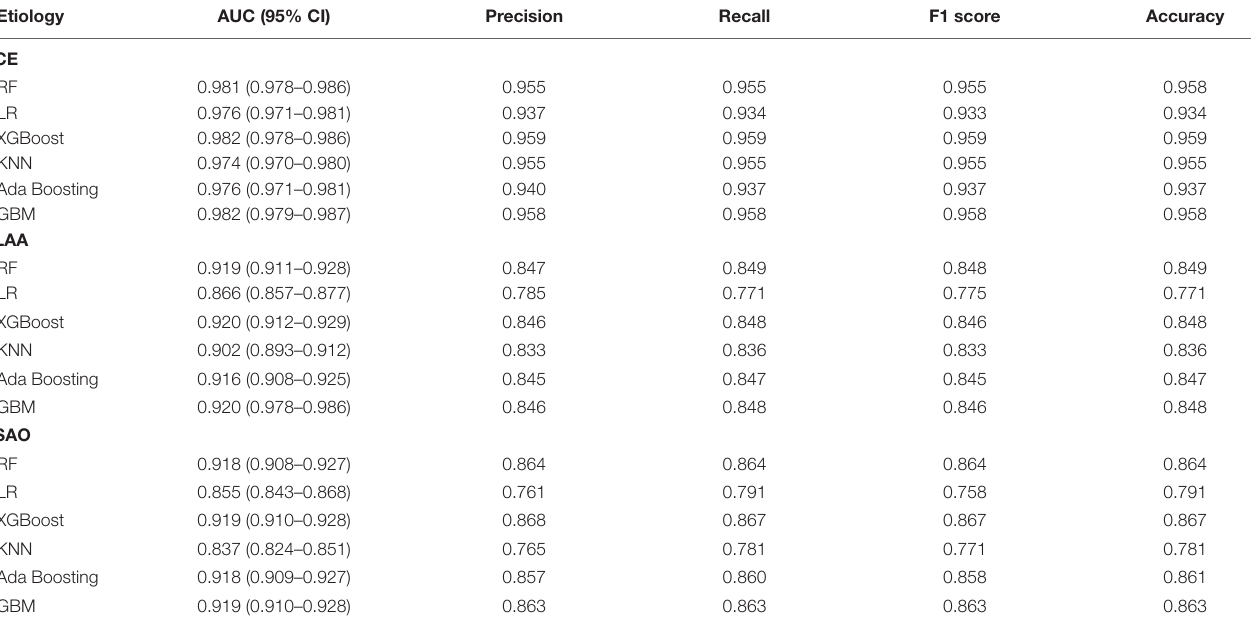
TABLE 2 | Comparison of six models to predict etiology. Etiology AUC (95% CI) Precision Recall F1 score